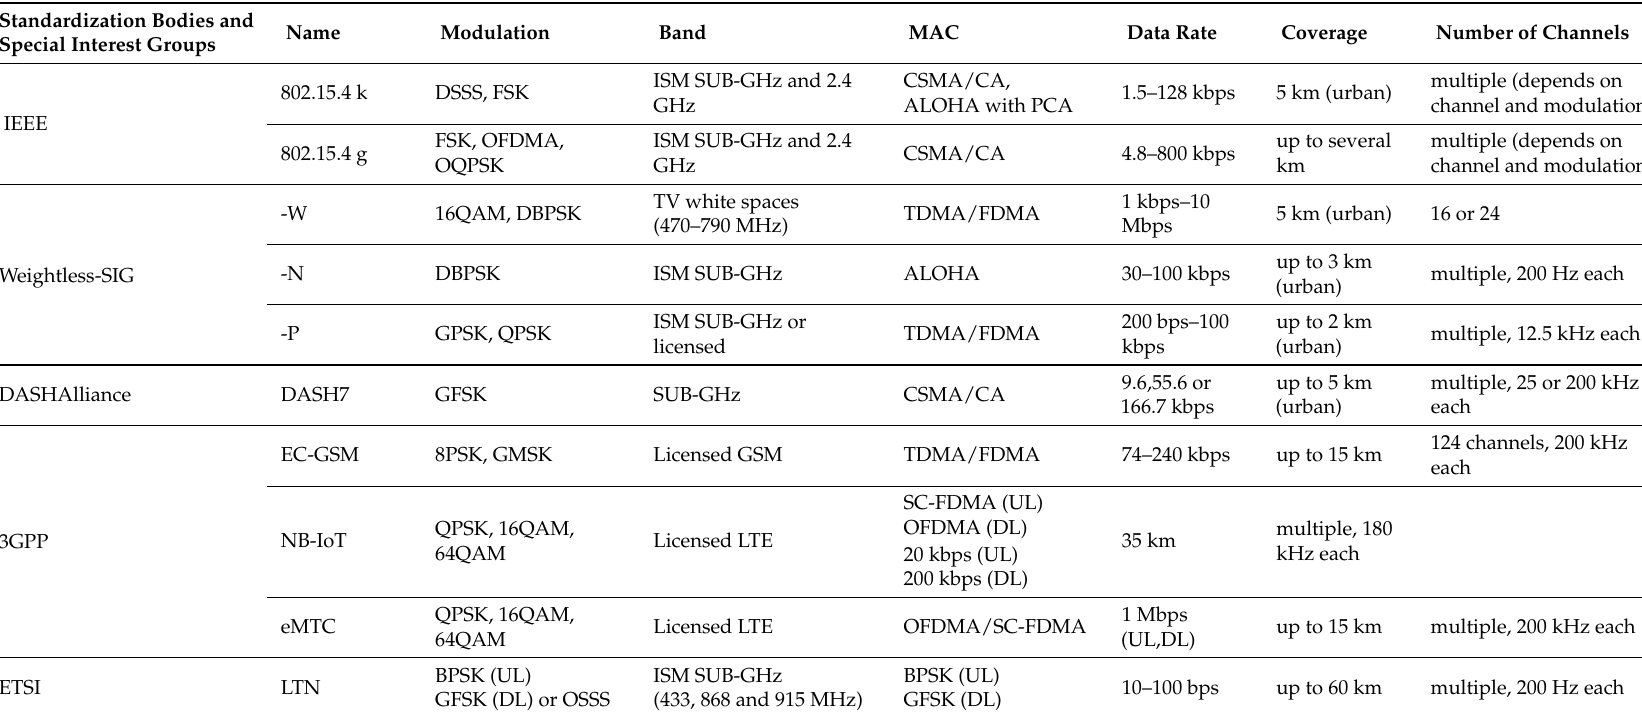
Table 2. Technical specifications for standardization bodies and special interest groups for IoT solutions [8]. ETSI, European Telecommunications Standards Institute. Standardization Bodies and Special Interest